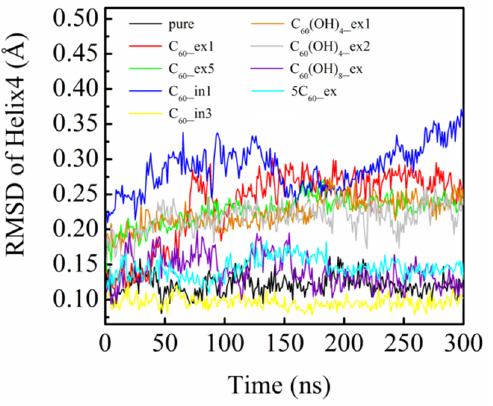
Figure 11. The calculated RMSD curves of helix4 in nine systems with respect to the β 2 AR crystal structure.